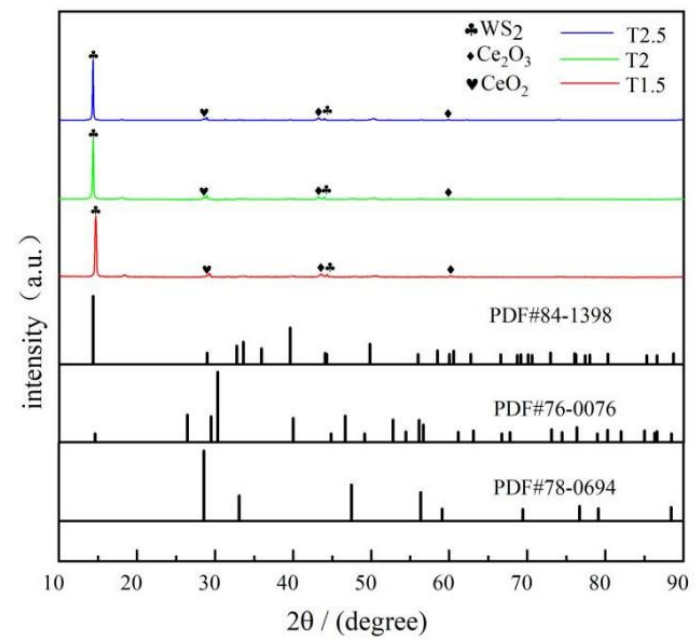
Figure 2. XRD paern of composite coatings. Figure 2. XRD pattern of composite